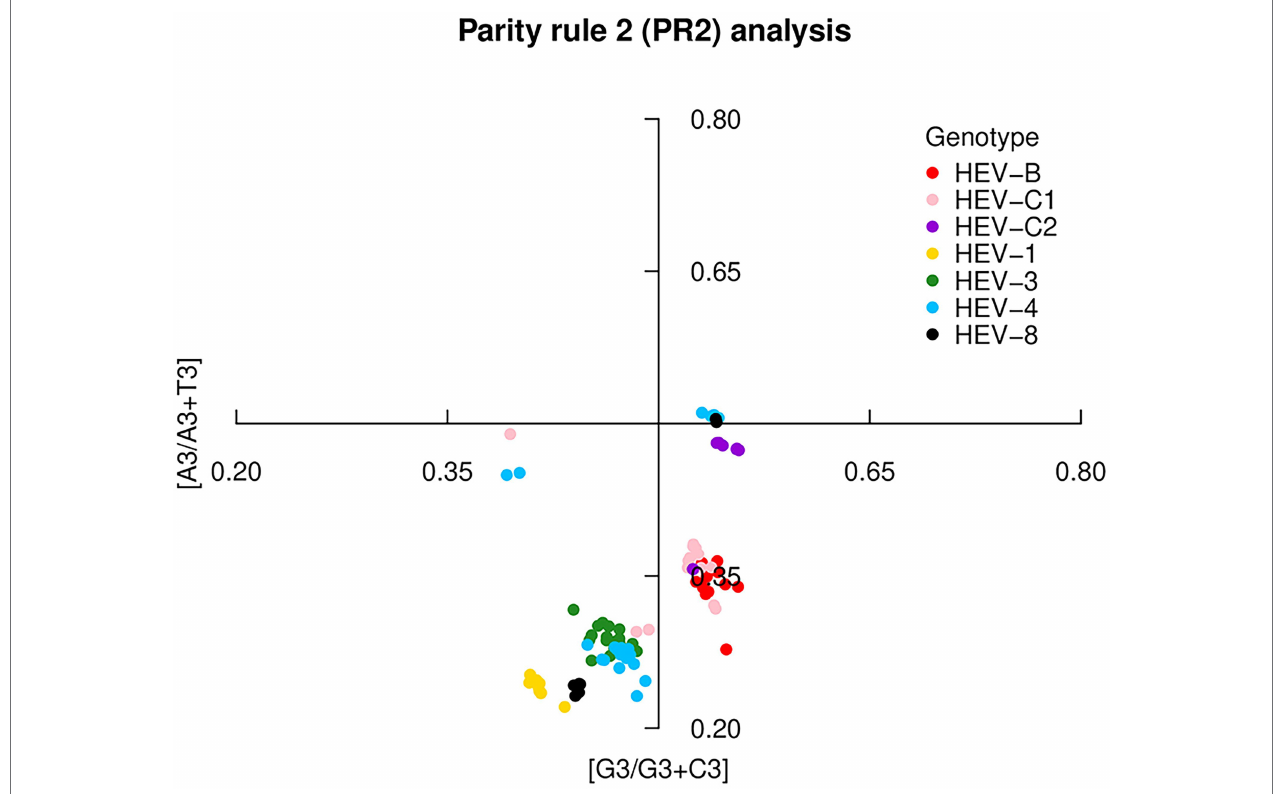
FIGURE 3 | Parity Rule 2 (PR2) plot based on the HEV complete coding sequences. The center of the plot, where the value of both coordinates was 0.5, indicated no bias in mutation or selection rates. Seven HEV genotypes were presented by